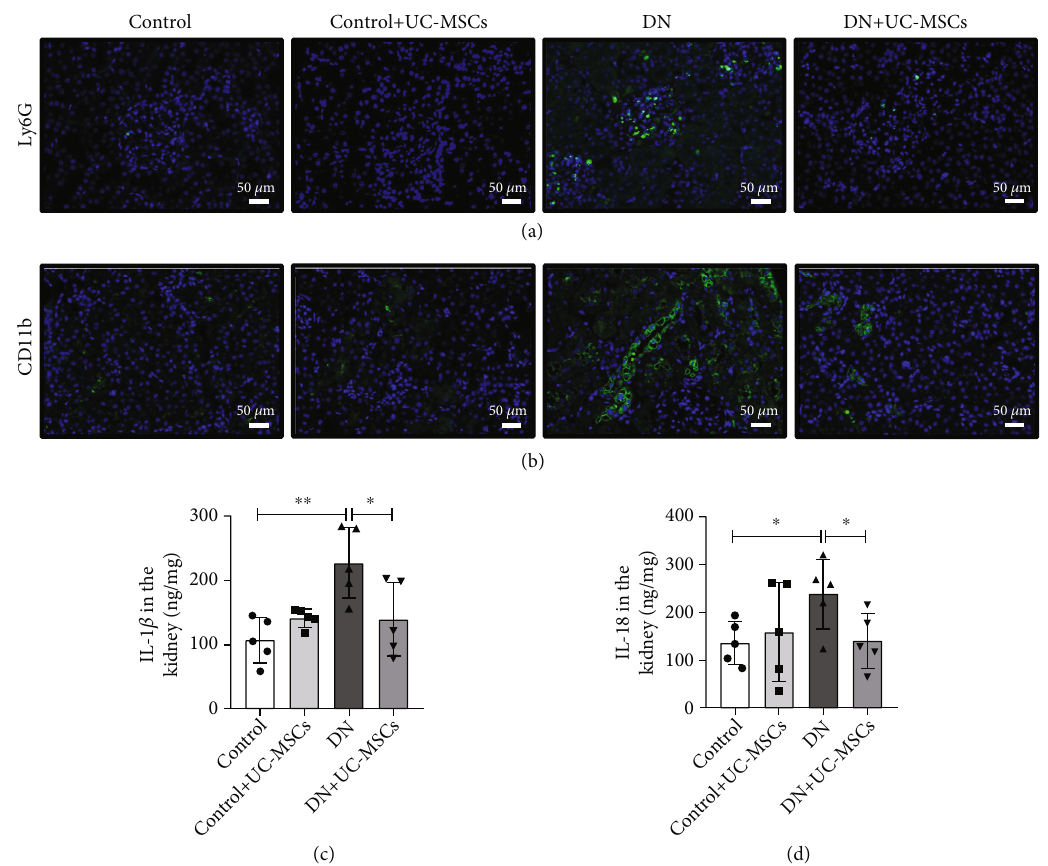
Figure 3: UC-MSC administration inhibits in fl ammation in DN rats. (a, b) Immuno fl uorescence staining of Ly6G + neutrophils or CD11b + macrophages in kidney tissues is presented ( n = 3 for each group). Scale bar, 50 μ m. (c, d) ELISA analysis of IL-18 and IL-1 β levels in kidney tissues from the control, control+UC-MSC, DN, and DN+UC-MSC groups. Data is shown as mean ± SD ( n = 4 ). ANOVA was used for comparison among multiple groups. ∗ p < 0 : 05 and ∗∗ p < 0 : 01